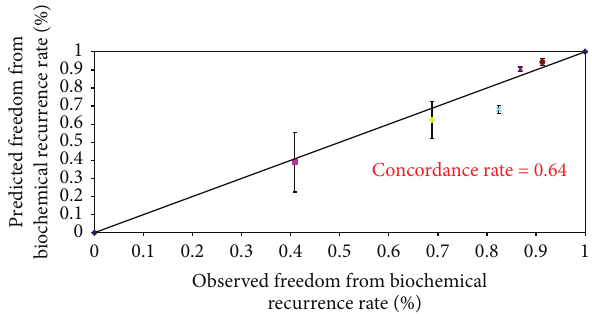
Figure3:Observedversuspredicted5-yearfreedomfrombiochem- ical recurrence rates according to the 1998 Kattan nomogram.